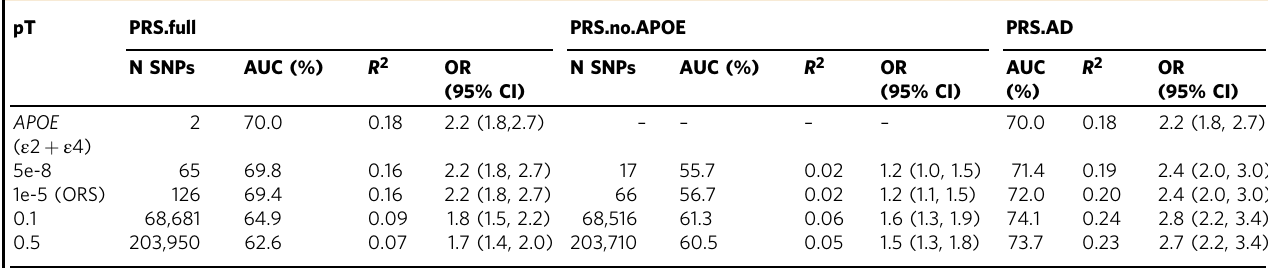
Table 2 PRS prediction accuracy for the AD case-control dataset using different p -value thresholds and methods to model APOE . pT PRS.full PRS.no.APOE